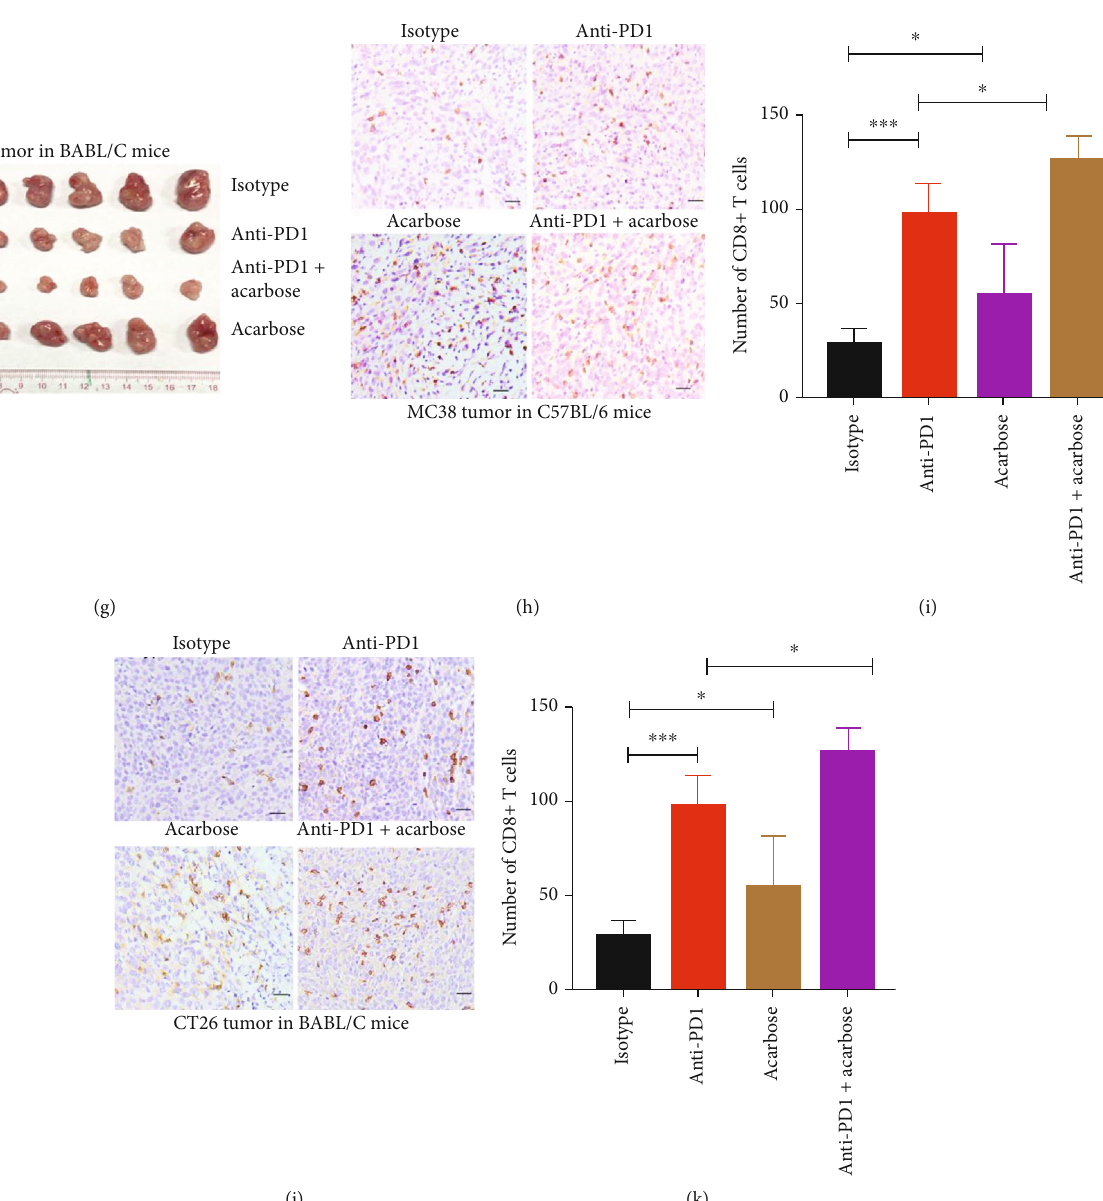
Figure 1: Acarbose inhibits colon tumor growth and enhances tumor immune responses to anti-PD1. (a) Schematic overview of experimental design combined for (b) – (k). (b – d) Tumor growth (b) and weight (c) from MC38 tumor-bearing C57BL/6 mice were shown ( n = 7 ). (e – g) Tumor growth (e) and weight (f) from CT26 tumor-bearing on BABL/C mice were shown ( n = 7 ). (h and i) Sections from MC38 subcutaneous tumors were stained with anti-CD8 antibody by immunohistochemistry (h), and CD8 + T cells in fi ltration were analyzed in (i). (j and k) Sections from CT26 subcutaneous tumors were stained with anti-CD8 antibody by immunohistochemistry (j), and CD8 + T cells in fi ltration were analyzed in (k). Scale bars: 100 μ m. Data were analyzed by two-way ANOVA (b and e) and t -test (c, f, i, and k). ns: no signi fi cance; ∗ p < 0 : 05 , ∗∗ p < 0 : 01 , and ∗∗∗ p < 0 : 001 . Error bars denote for the